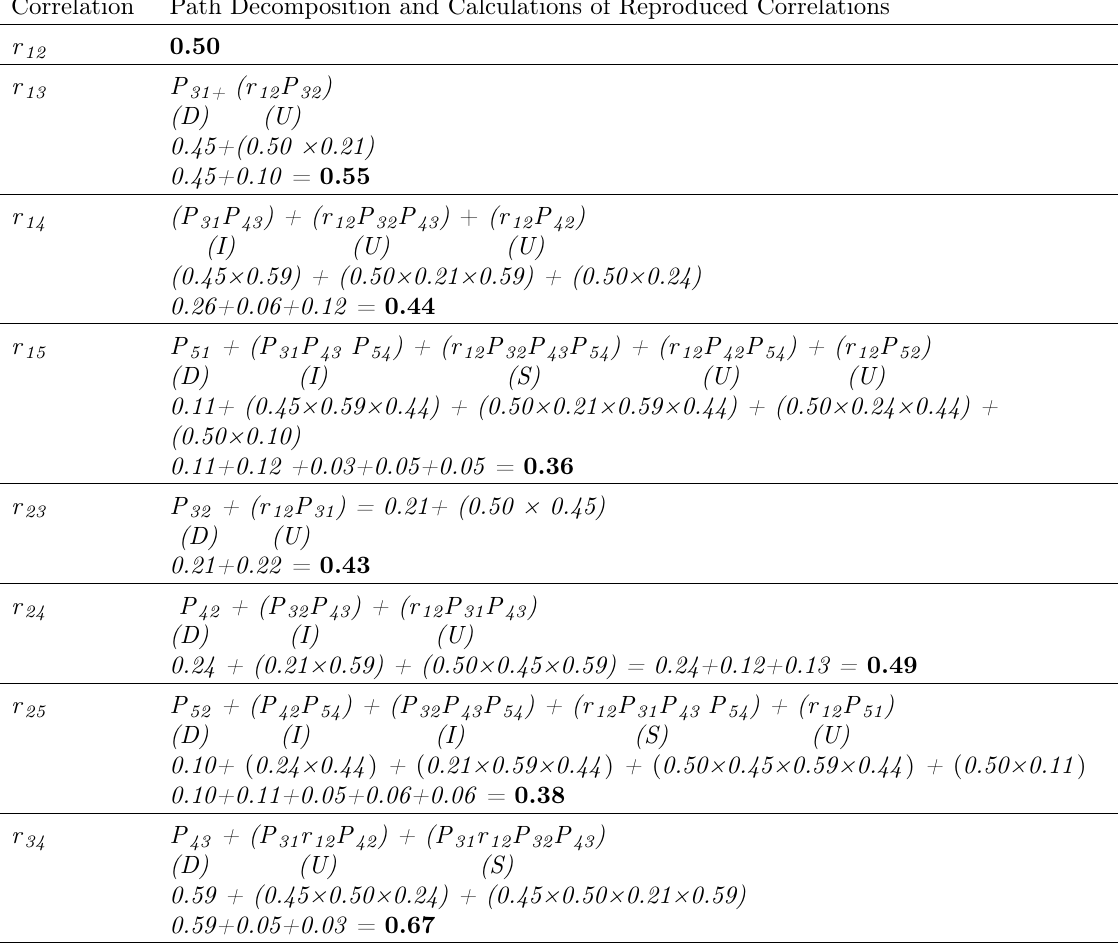
Table 7. Path Decompositions and Calculation of Reproduced Correlations for the Exogenous and Endogenous Factors in the Revised Model in Figure